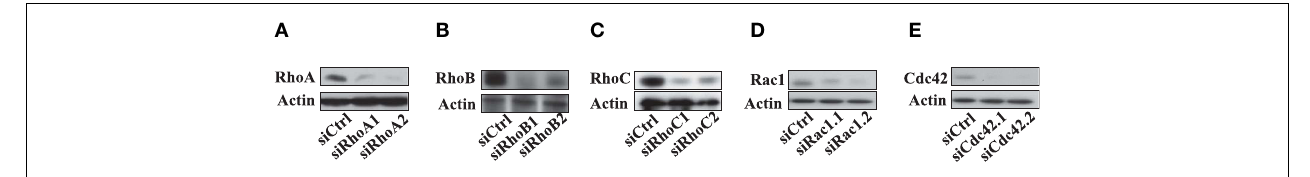
western blot, and actin was used as a control of a uniform loading. RhoA, RhoB, RhoC, Rac1, and Cdc42 expressions were analyzed to test their respective specific siRNAs efficiencies (A–E) .